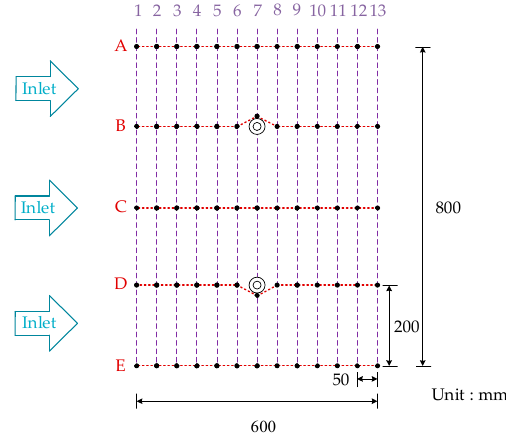
Figure 5. Layout of measuring points.